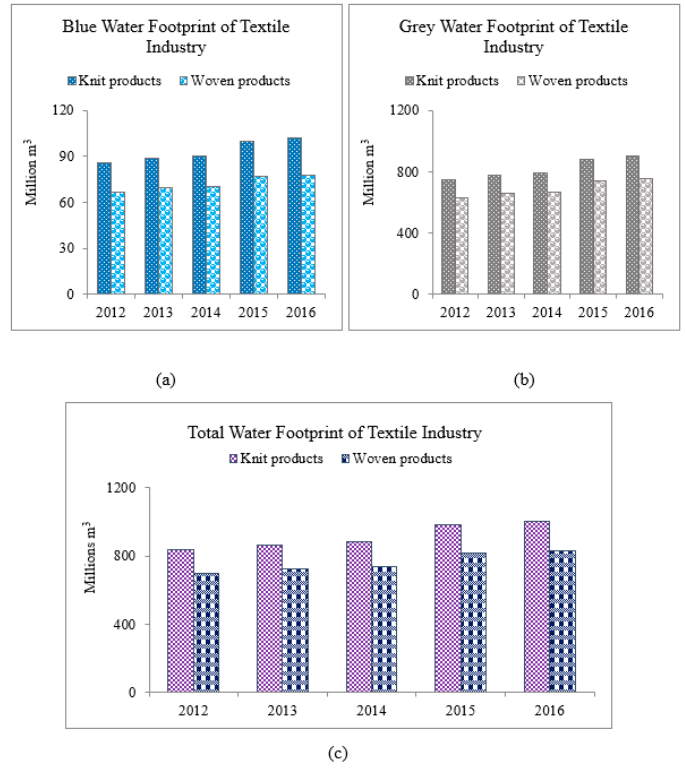
Figure 7. Water footprint of textile industry for knit and woven products: ( a ) blue water footprint, ( b ) grey water footprint and ( c ) total water footprint.